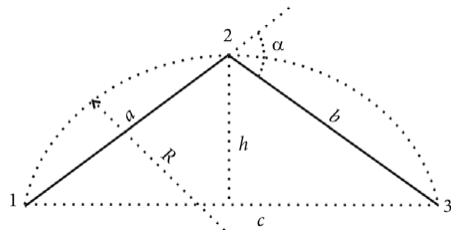
Fig. 3. Visualization of central trajectory and confidence interval